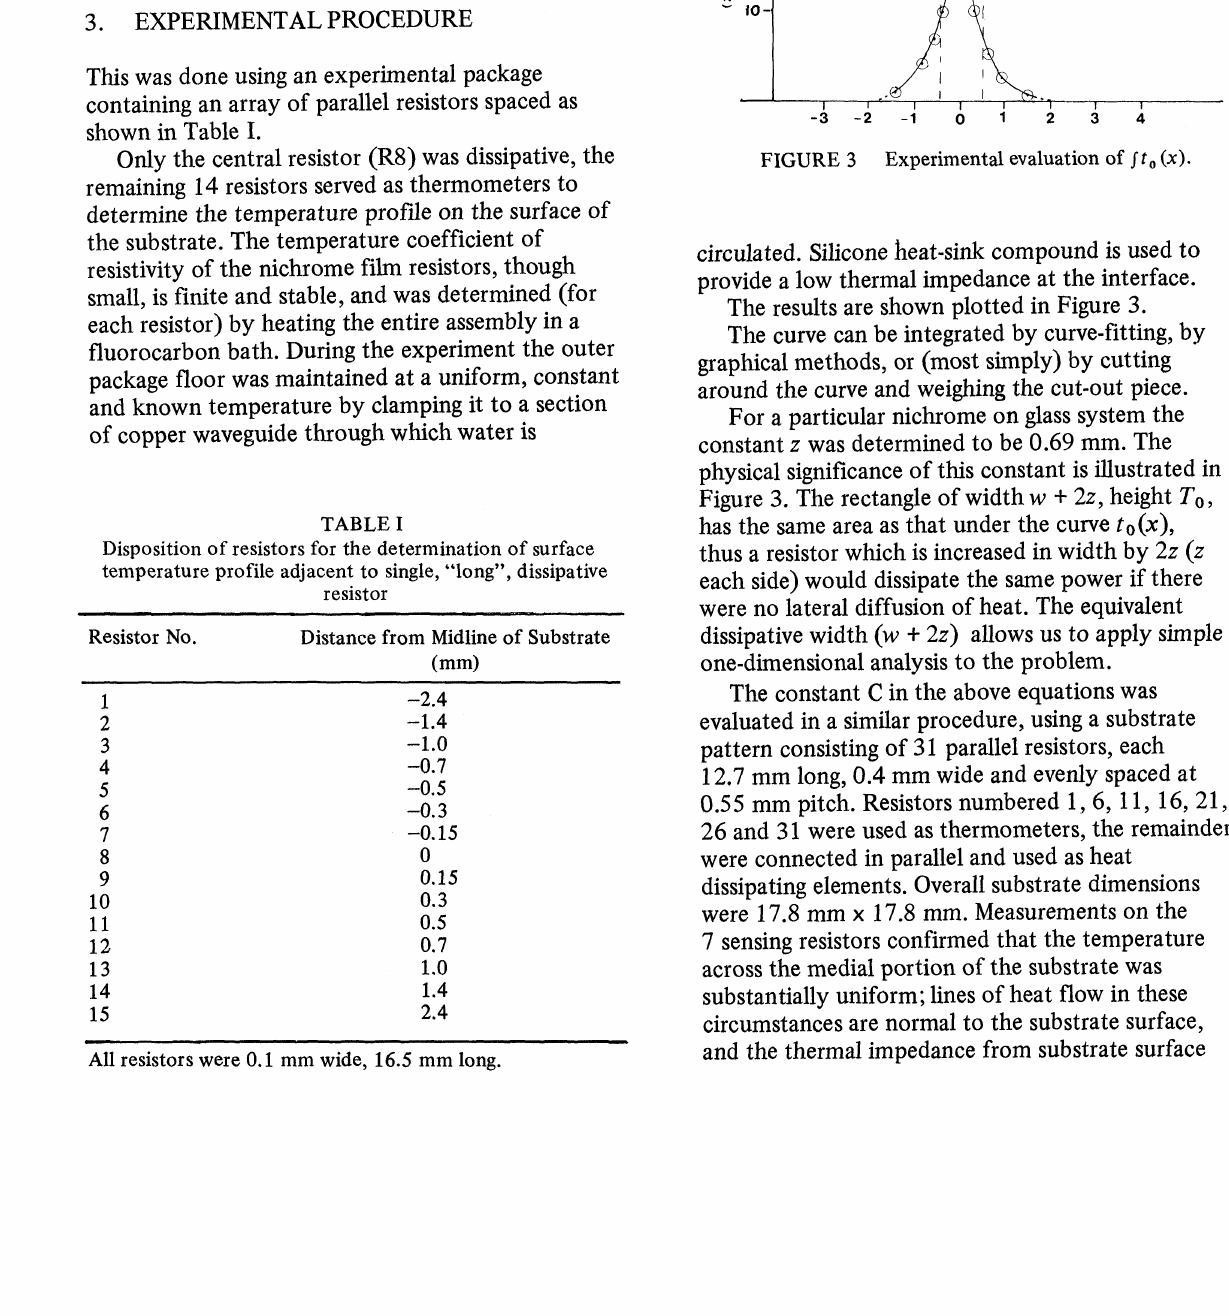
FIGURE 3 Experimental evaluation of J’to